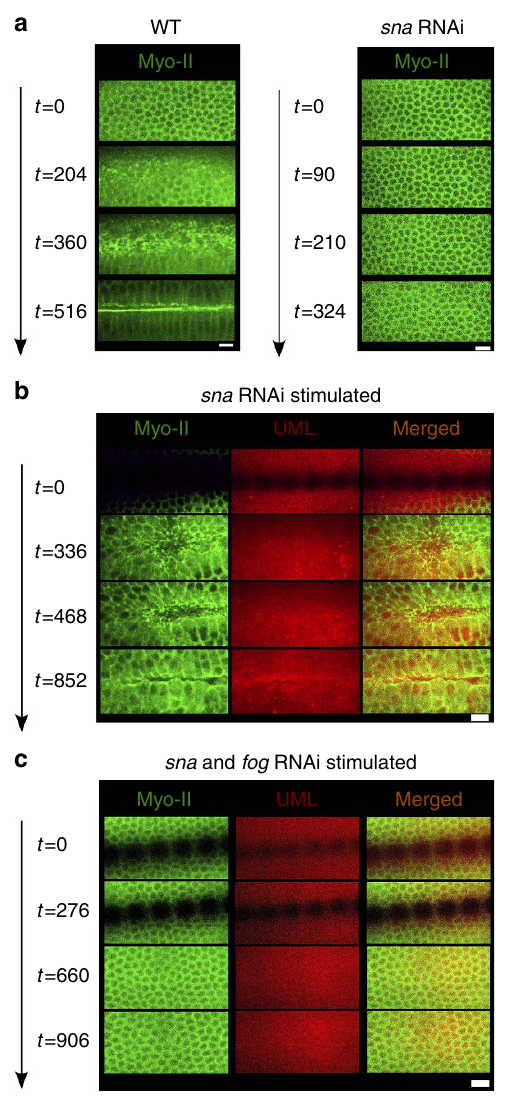
Figure 5 | Rescue of medio-apical Myo-II by sna -like mechanical pulses is Fog-dependent. ( a ) Myo-II apical accumulation, followed by mesoderm invagination in the WT, all of which are impaired in sna RNAi-injected embryos ( N ¼ 6 in each case, P ¼ 2 (cid:3) 10 (cid:2) 3 , exact Fisher test). ( b ) Apical accumulation of Myo-II and mesoderm invagination after the initiation of magnetic stimulation of sna -dependent pulsations in sna RNAi-injected embryos (Myo-II in green, UML in red). Representative of n ¼ 6 of the N ¼ 6 sna RNAi embryos ( P ¼ 2 (cid:3) 10 (cid:2) 3 , exact Fisher test, Myo-II apical accumulation ( n ¼ 6), full invagination ( n ¼ 4), partial invagination ( n ¼ 0)). ( c ) Sqh-GFP UML-loaded embryos injected with Sna RNAi and Fog RNAi and positioned close to the micro-magnet array, the ensemble being submitted to a magnetic field that is pulsed at a rate that mimics the rate of sna -dependent pulsations. Representative of n ¼ 7 of N ¼ 8 embryos ( P ¼ 5 (cid:3) 10 (cid:2) 3 , exact Fisher test). The micro-magnet array was removed after 336s, so as to image the mesoderm directly above the individual micro-magnets. Scale bars, 10 m